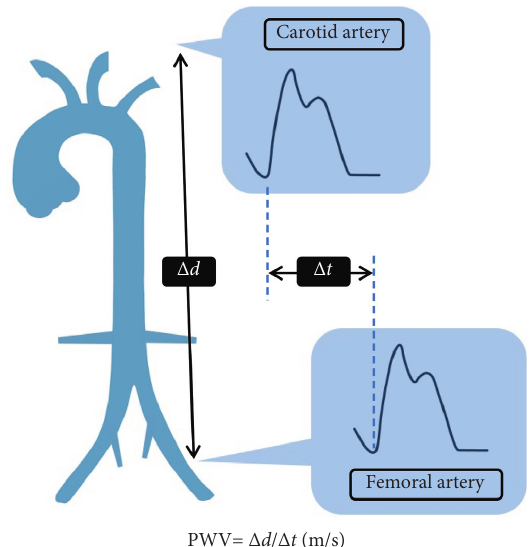
Figure 1: Carotid-femoral pulse wave velocity measurements. △ d obtained by subtracting the distance from the carotid measurement site to the sternal notch and from the sternal notch to the femoral measurement site. △ t obtained by time interval between the R waves from the ECG of carotid and femoral